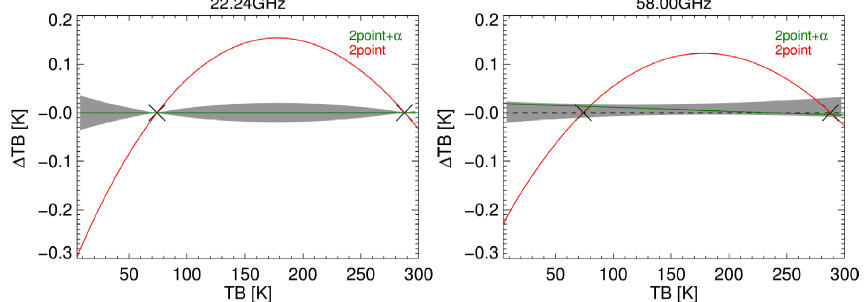
Fig. 5. The effect of the non-linearity parameter α of the radiometer system and its uncertainty on calibrated T b for two exemplary HATPRO- G2 channels. The exact 4-point scheme solution serves as the reference (zero line). Red: 2-point calibration ( α =1, no noise injection), green: 2-point calibration using α from the original 4-point calibration performed at the beginning of RHUBC-II, shaded area: uncertainty resulting from random uncertainty of α